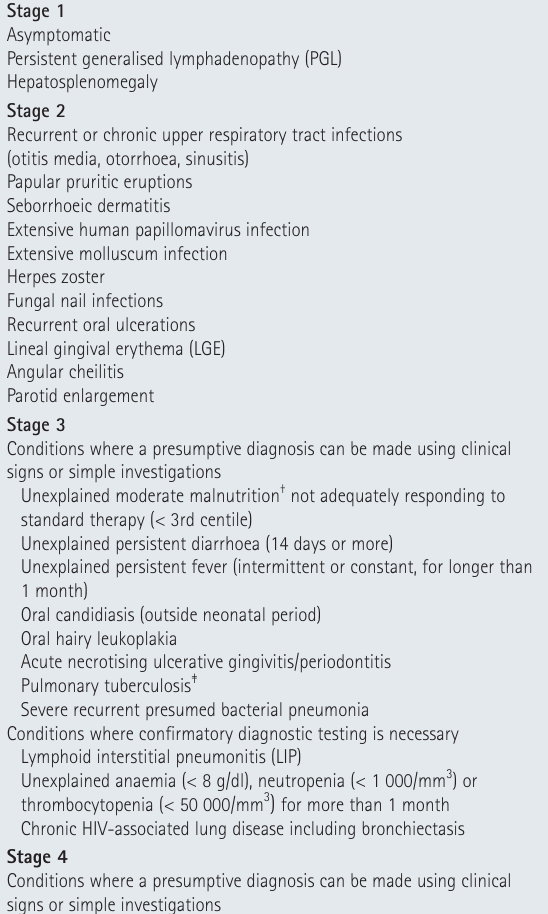
TABLE II. REVISED WHO CLINICAL STAGING OF HIV FOR INFANTS AND